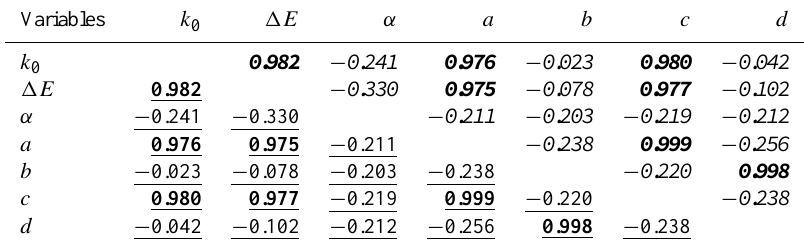
Table 5. Estimated parameters of the HYDRUS-1D model: Air Diff. = Molecular diffusion coefficient of carbon dioxide in air (mm − 2 d − 1 ); Water Diff. = Molecular diffusion coefficient of carbon dioxide in water (mm − 2 d − 1 ); OCDP microorganisms = Optimal CO 2 production by soil microorganisms for the entire soil profile (µmolm − 2 s − 1 ); OCDP roots = Optimal CO 2 production by plant roots for the entire soil profile (µmolm − 2 s − 1